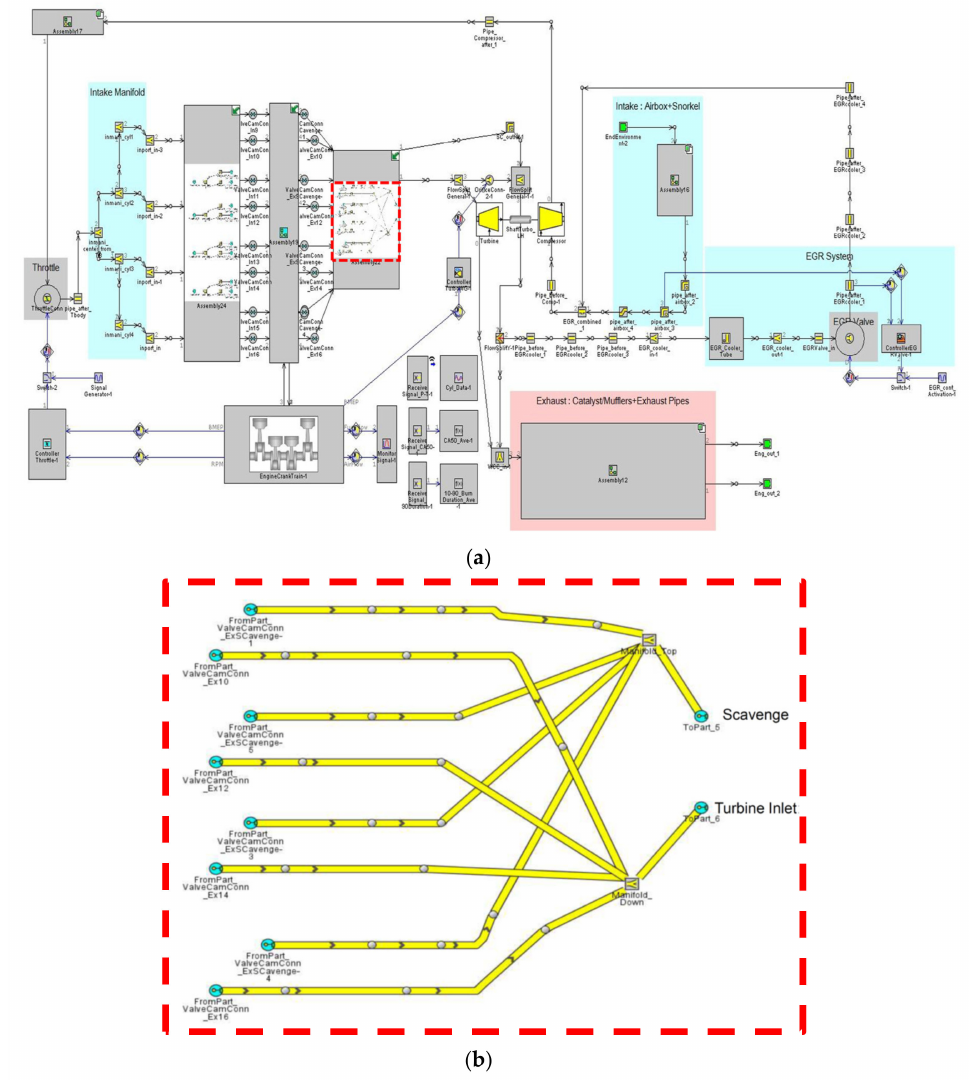
Figure 4. GT power model of the DEP engine: ( a ) Overall engine model; ( b ) exhaust